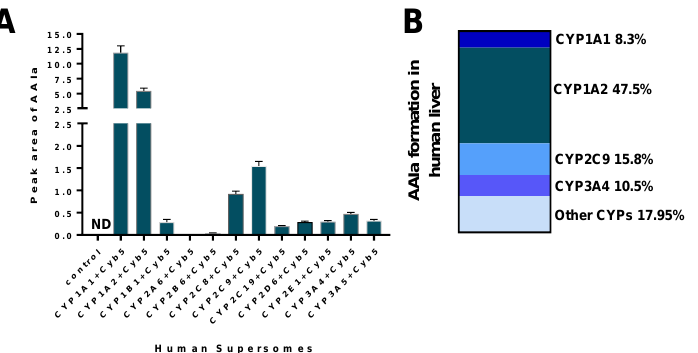
Figure 4. AAIa formation by human recombinant CYP enzymes in the presence of cytochrome b 5 (Cyb5) ( A ); Data shown are mean ± SD ( n = 3). ND, not detected. Data previously published in [92,95,96] ( A ); Contributions of CYP enzymes to AAIa formation in human livers ( B ).